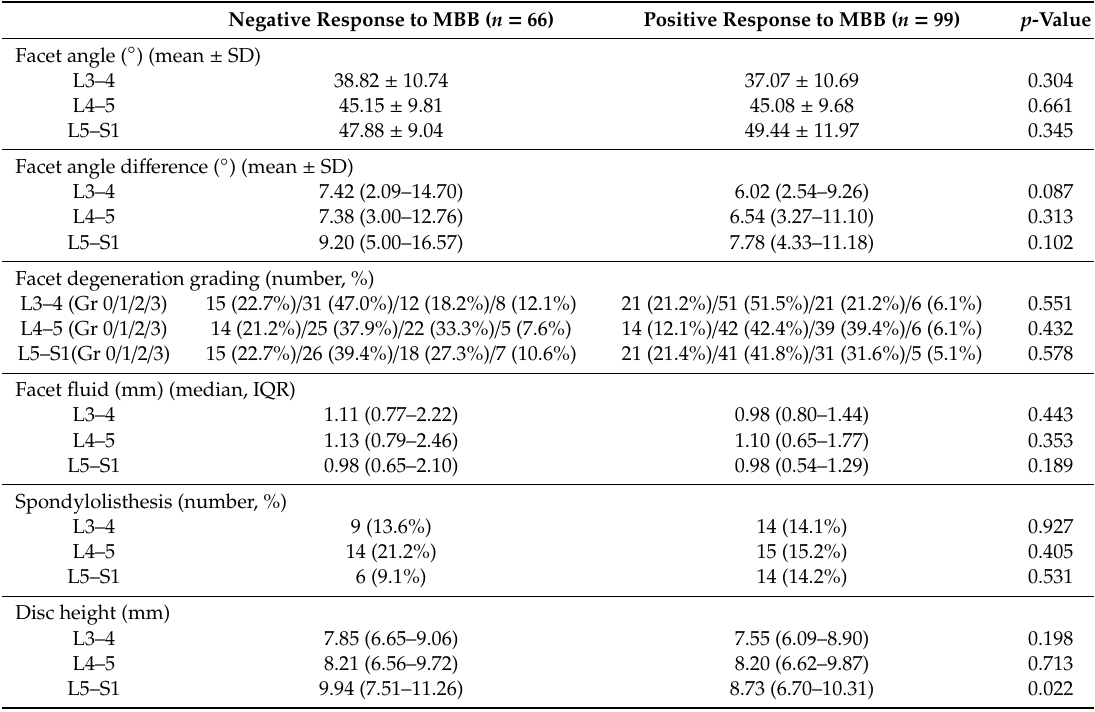
Table 2. Characteristics of the negative and positive responders after the medial branch block.